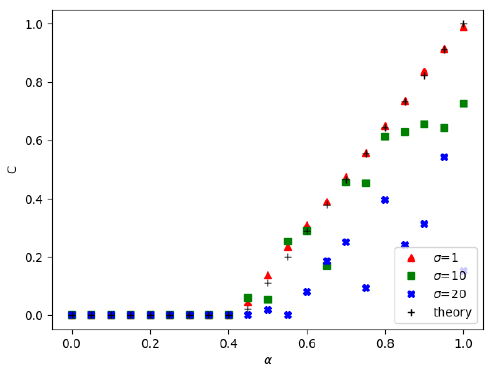
Figure 12. Comparison of concurrence: N =